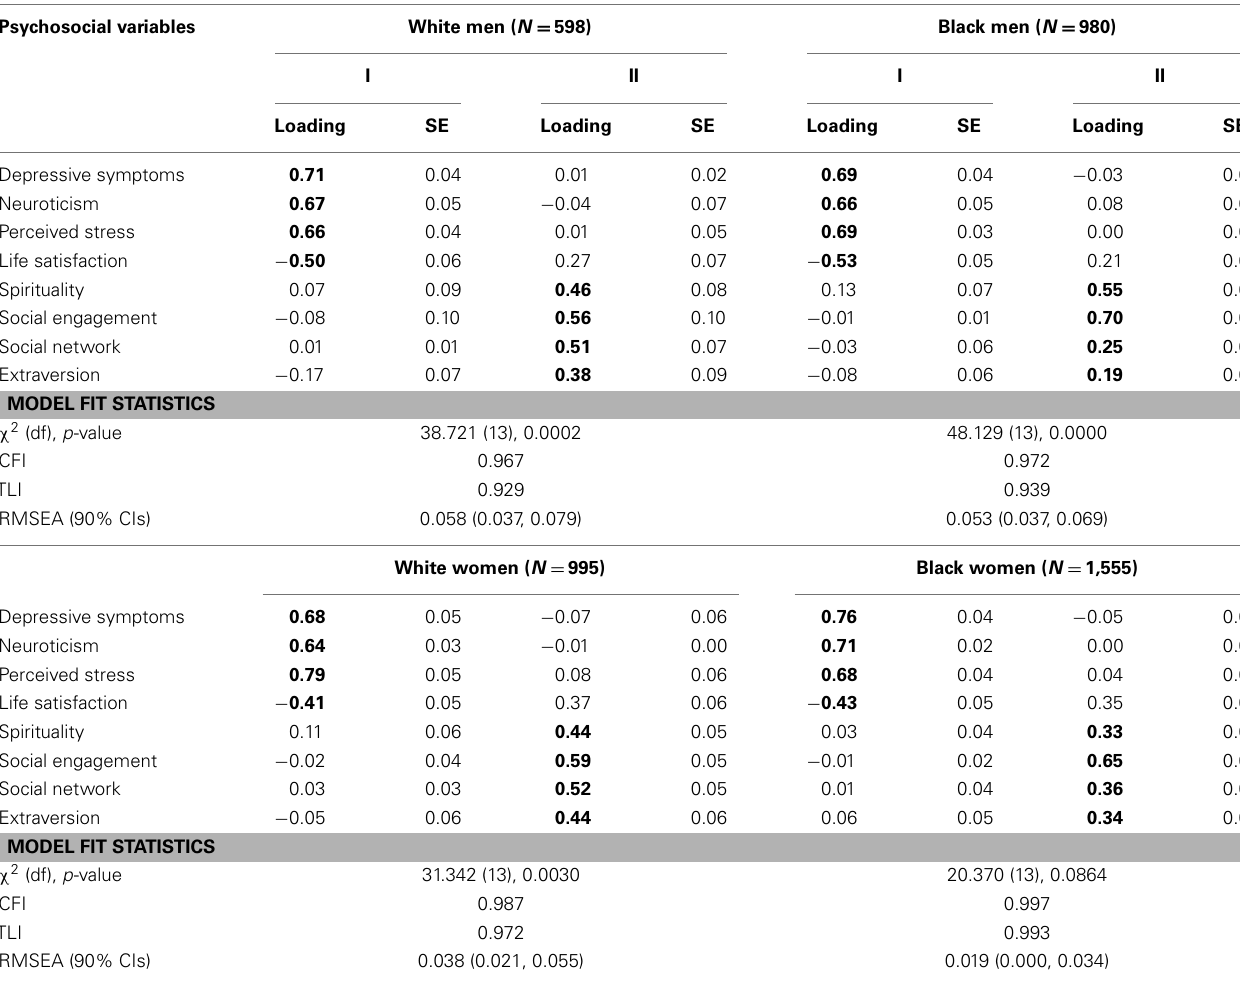
Table 4 | Factor loadings and model fit by race–sex